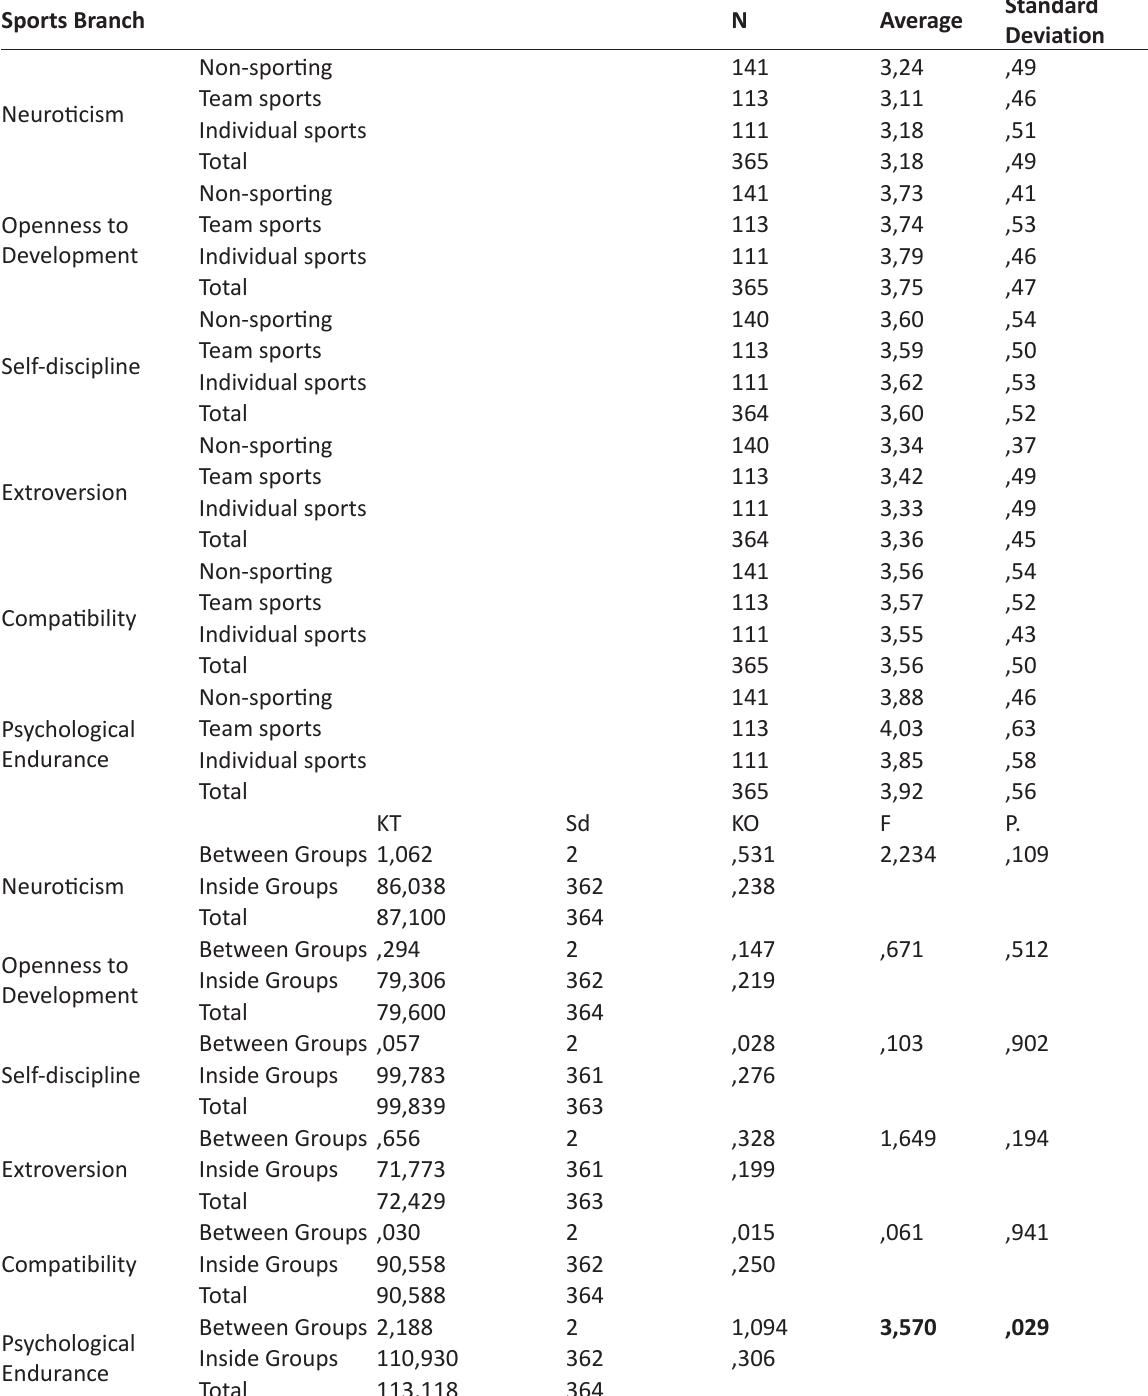
Table 5. Findings related to the difference between psychological endurance and personality characteristics according to sport branch